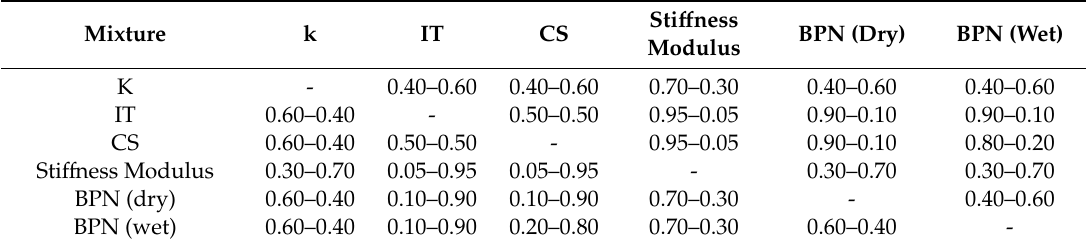
Table 5. Importance among variables of study.